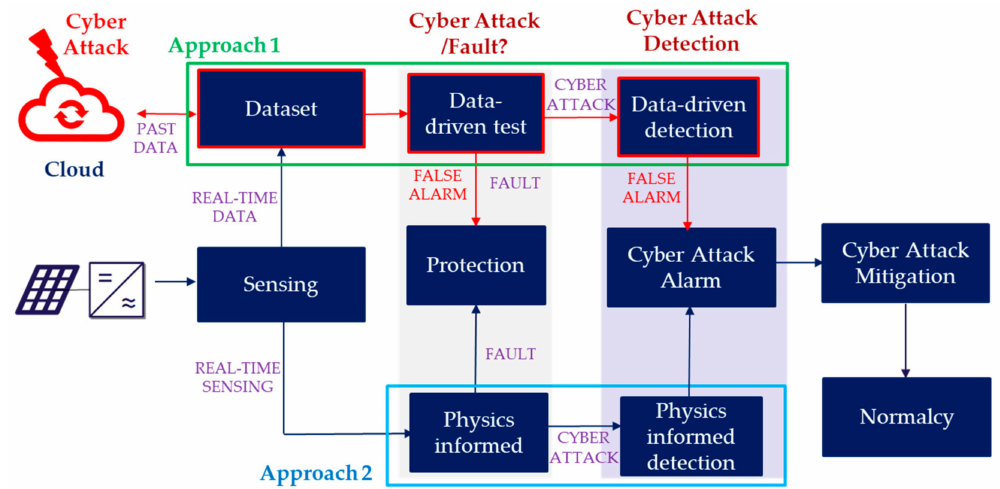
Figure 16. A perspective of cybersecurity approaches for PV systems: comparative evaluation between AI and physics- informed